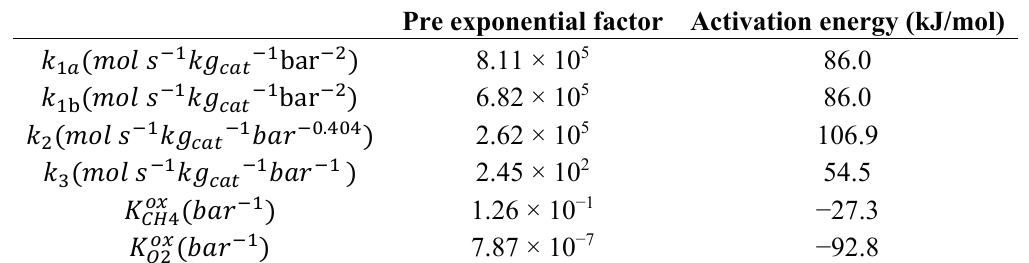
Table 2. Kinetic parameters for methane combustion, reforming and water gas shift